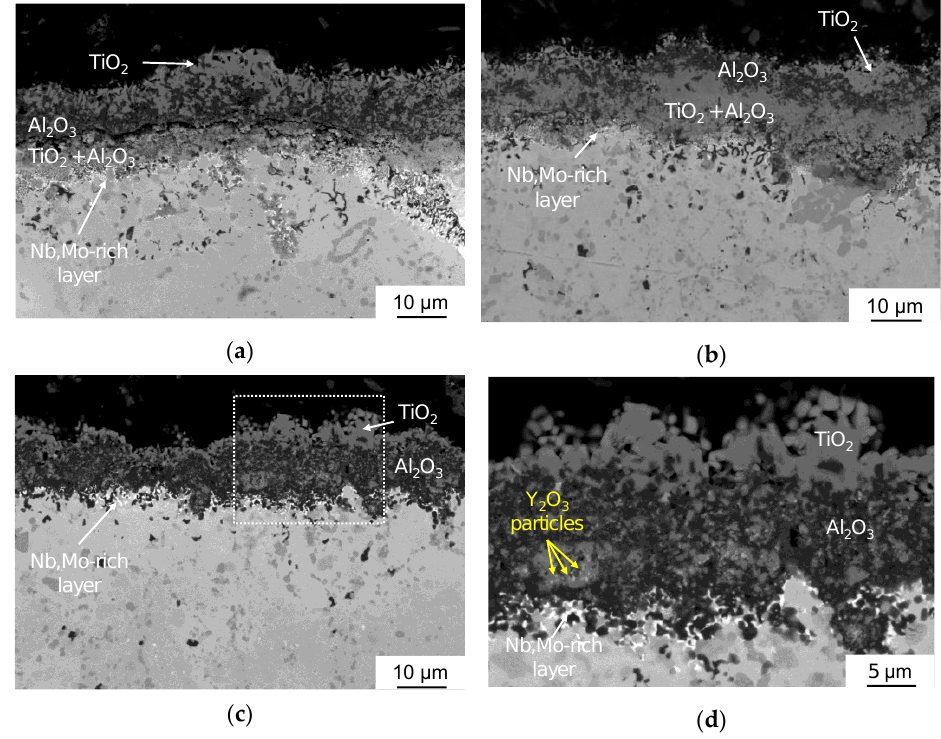
Figure 10. The cross-sectional oxidized layer image of alloys 0.2C ( a ), 1.5Si ( b ), and 1.5Y 2 O 3 ( c ) after isothermal annealing at 1100 °C and a magnified image of the area highlighted by a white dotted line ( d ).